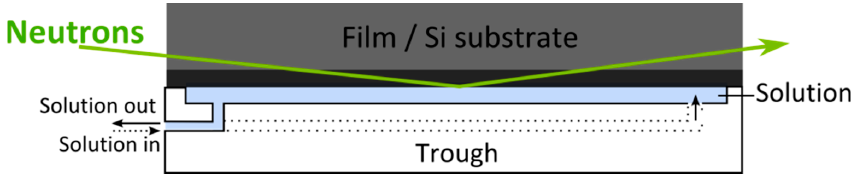
Figure 5. Schematic of a typical solid/liquid cell.